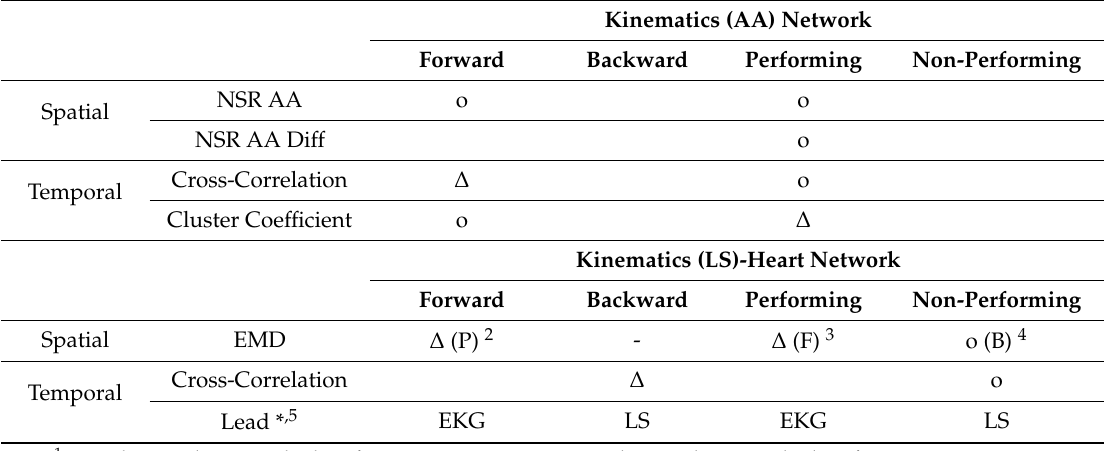
Table 1. Summary of the connectivity results, where symbols 1 are shown to indicate which category shows higher values.